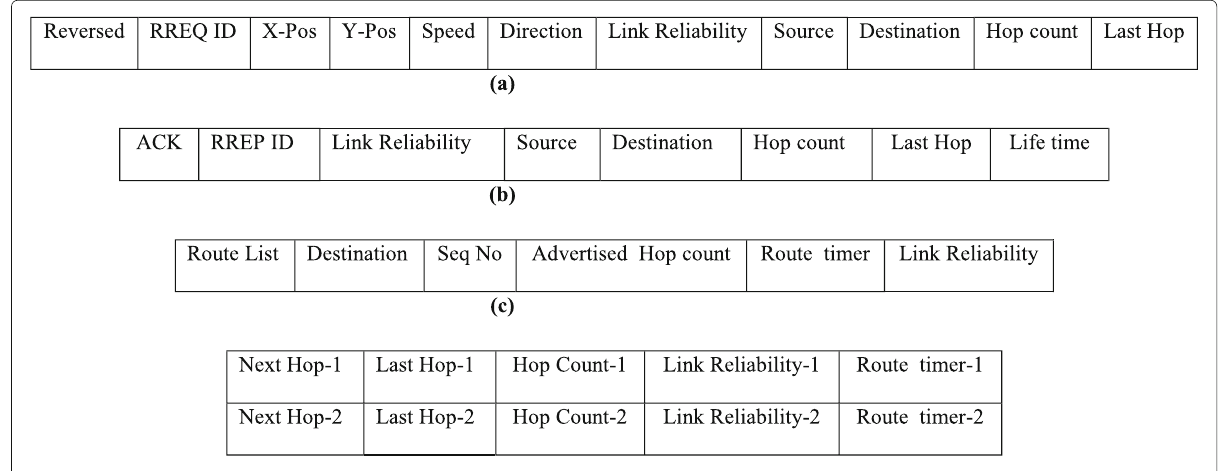
Fig. 3 Route structure of RLLMR. a RLLMR RREQ Contents, b RLLMR RREP Contents, c RLLMR Routing